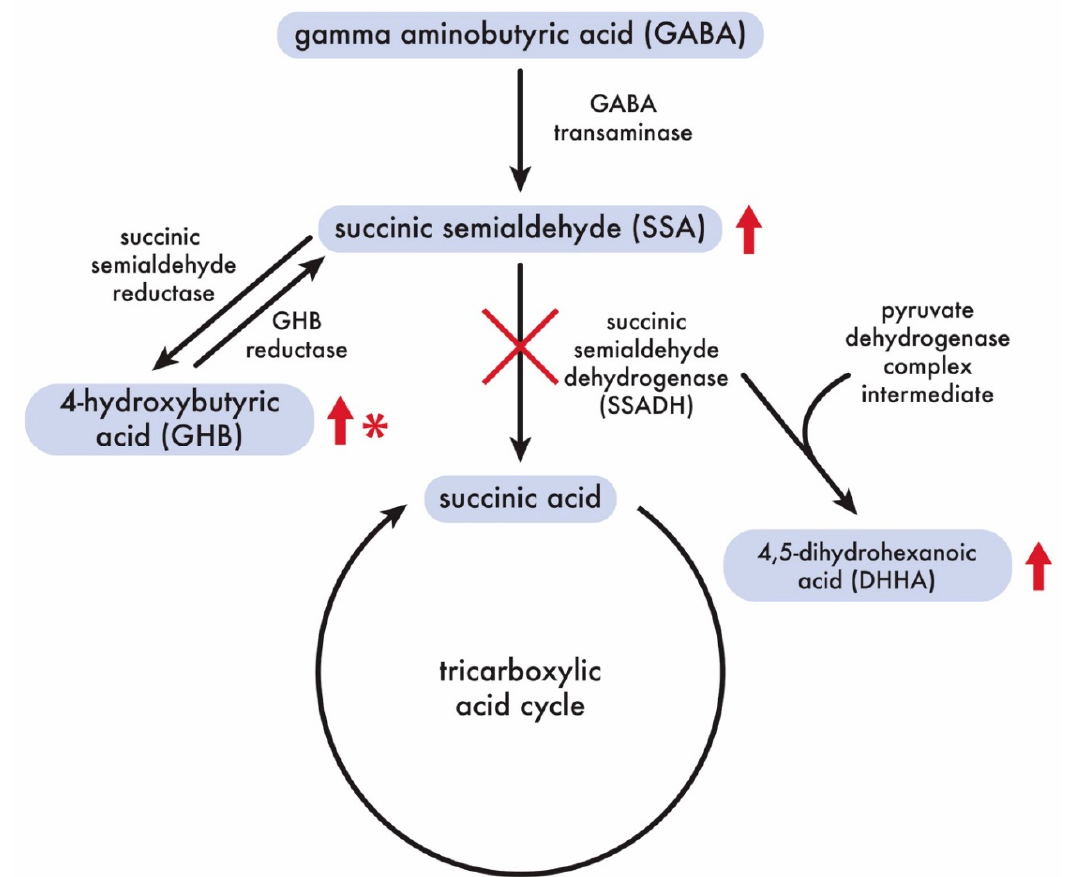
Figure 7. GABA catabolism pathway. In Saluki dogs with SSADH deficiency, levels of SSA and DHHA are elevated in urine, serum, CSF and brain, and GHB is elevated in serum, CSF and brain (red arrows) as in people with SSADH deficiency. Unlike in people, where GHB is elevated in urine (red arrow), the level of GHB in urine (red *) in Saluki dogs with SSADH deficiency is normal.